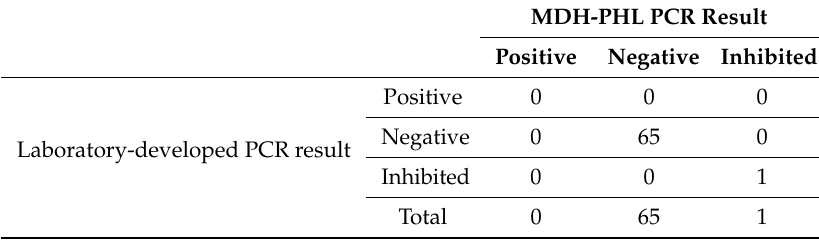
Table 3. Comparison of the laboratory-developed PCR assay with the real-time PCR assay performed by the